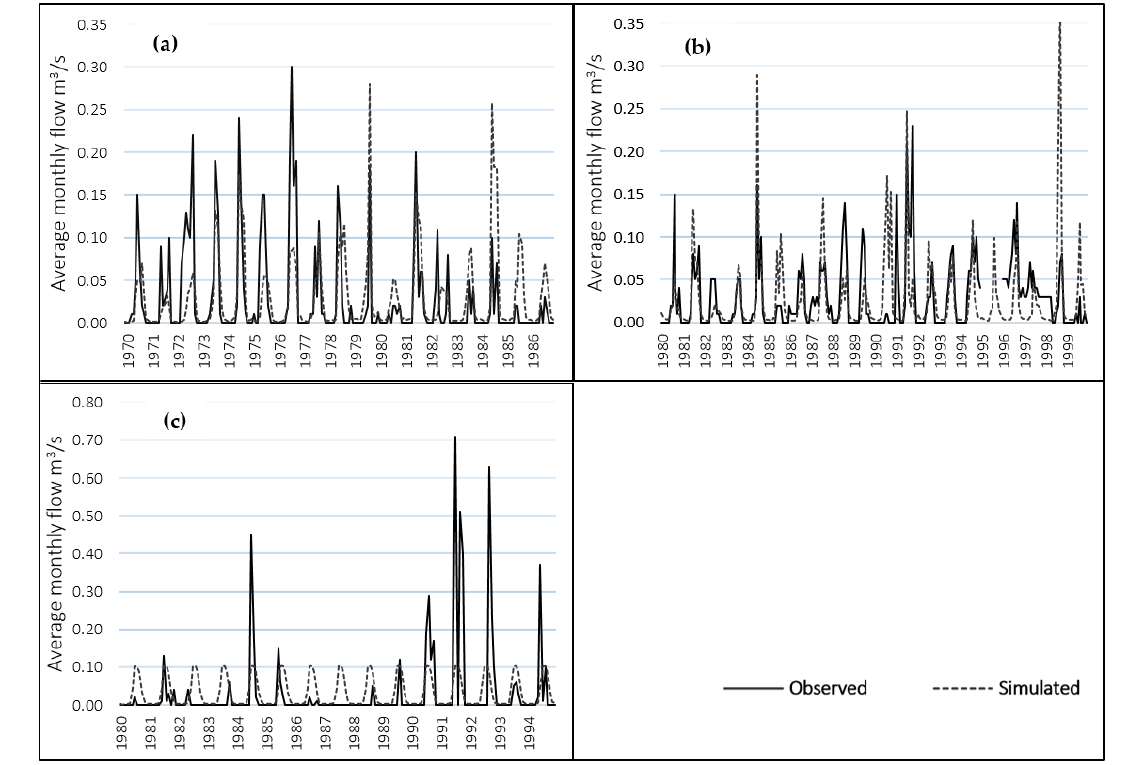
Figure 4. Monthly flow rate observed and simulated in Texcoco River ( a ), Chapingo River ( b ) and San Bernardino River ( c ).